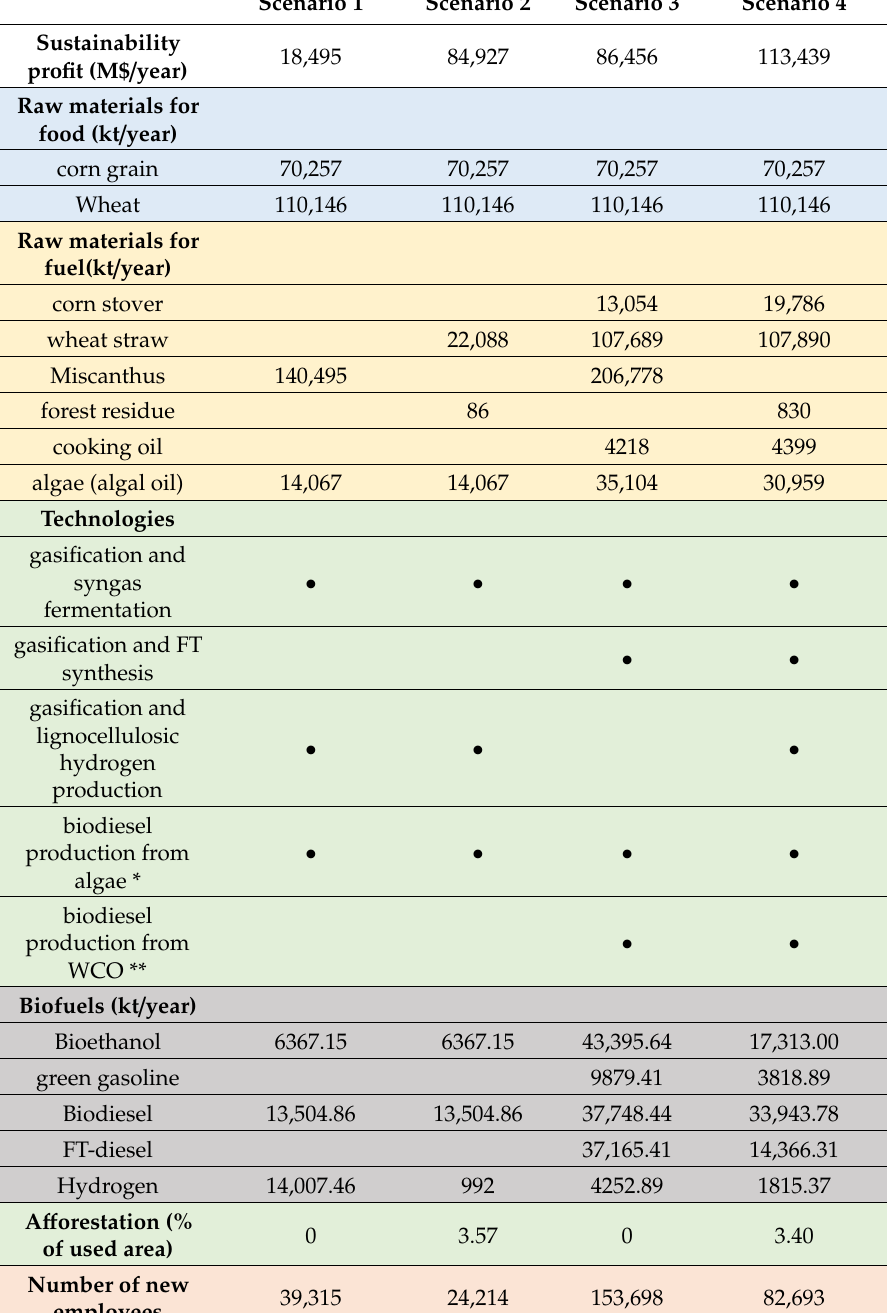
Table 5. Main results of sustainability optimization for di ff erent